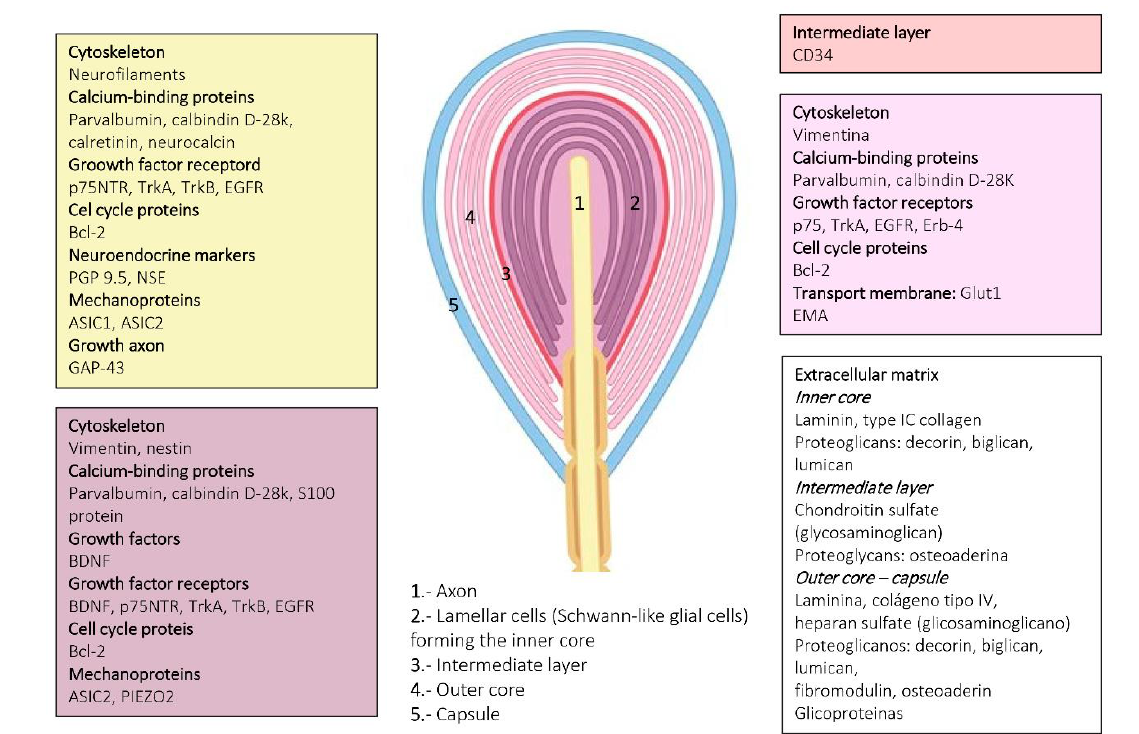
Figure 8. Schematic representation of Pacinian corpuscles showing the proteins detected in the different corpuscular components using immunohistochemistry. Axon: yellow box; lamellar cells: purple box; capsule: pink box; extracellular matrix: white box.